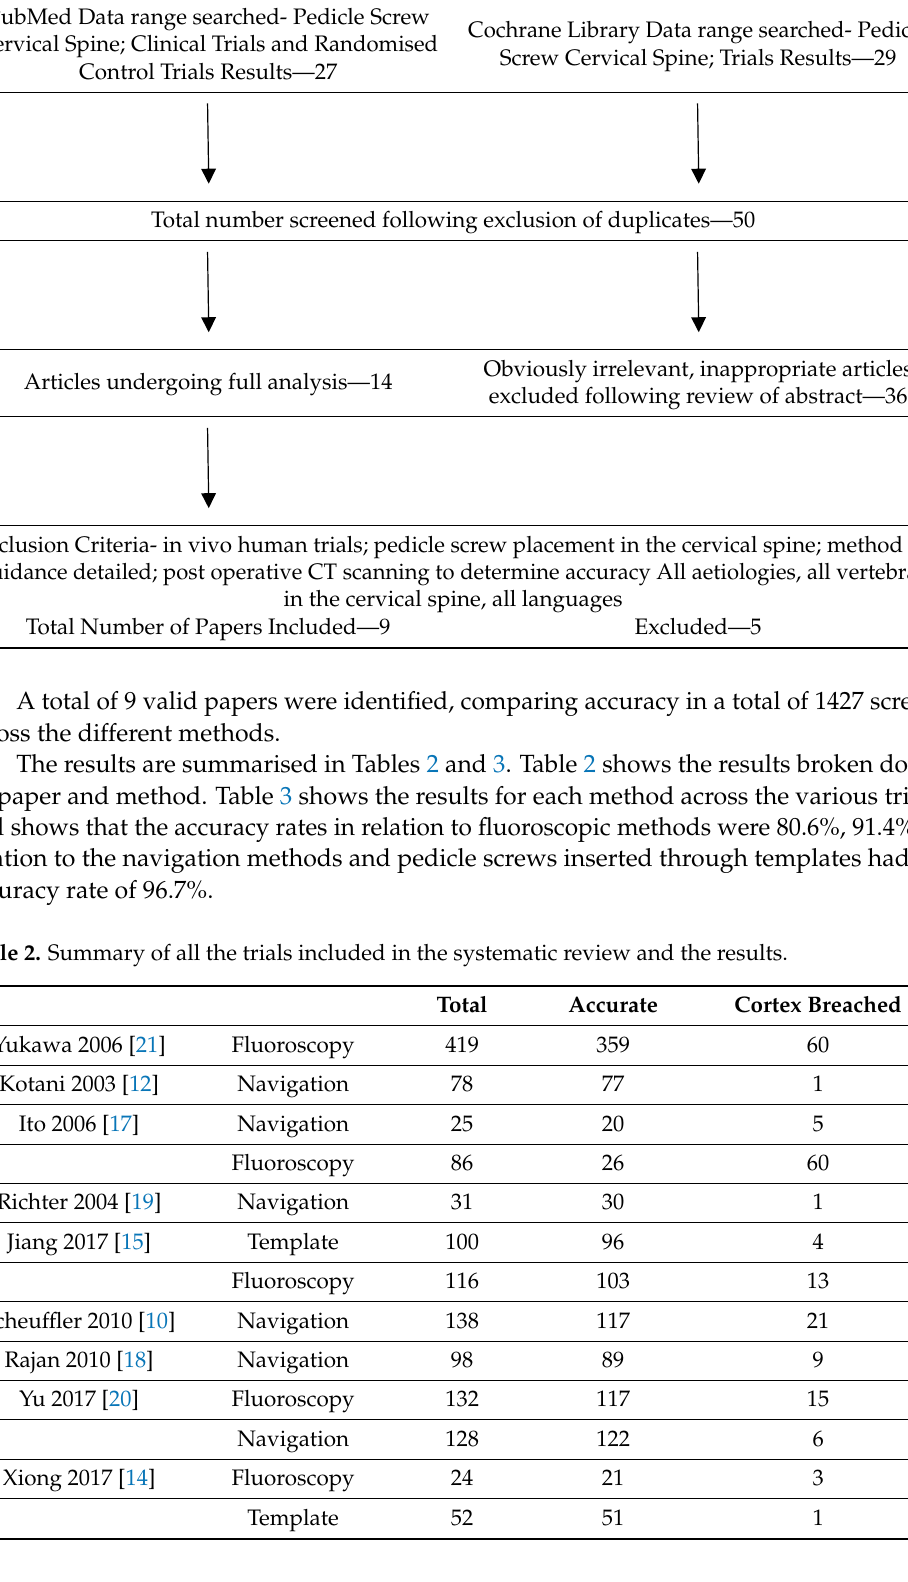
3 Table 1. PRISMA diagram outlining how the systematic review was conducted. Pedicle Screw Accuracy in the Cervical Spine- A Systematic Review